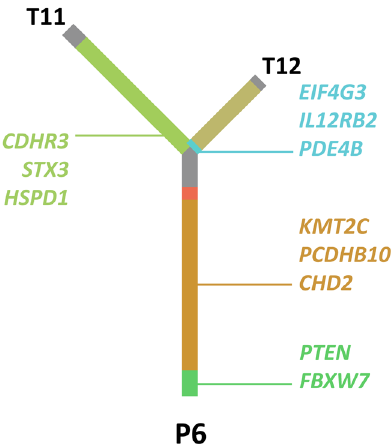
Fig. 4 The Phylogenetic tree of tumor samples from patient P6. The trunk of the tree represents clusters of mutations that are common to both tumor samples, likely representing truncal mutations. The lengths of the trunk and the branches of the tree are proportional to the number of corresponding mutations. Major subclones are labelled in the same color as in Fig. 3b. Gene labels refer to mutations in genes that are identi fi ed in T11 only, T12 only, or common to both tumors. The gene labels are